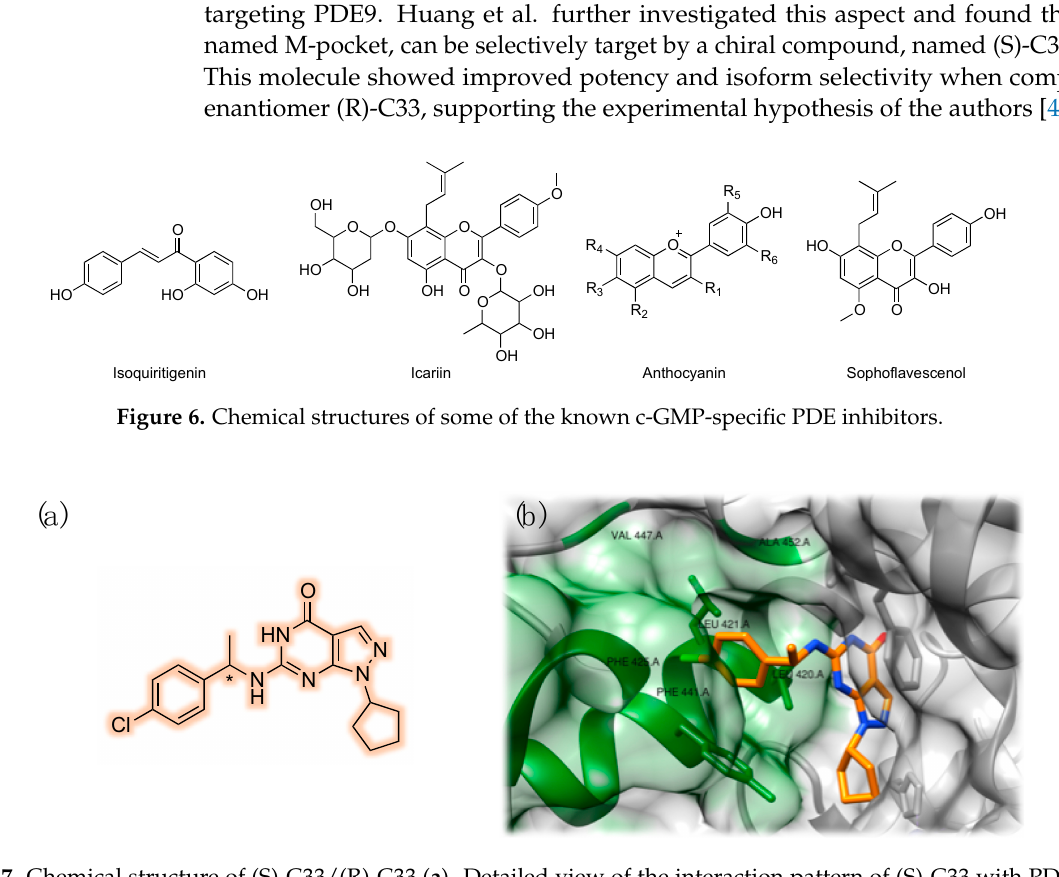
Figure 6. Chemical structures of some of the known c-GMP-specific PDE inhibitors.